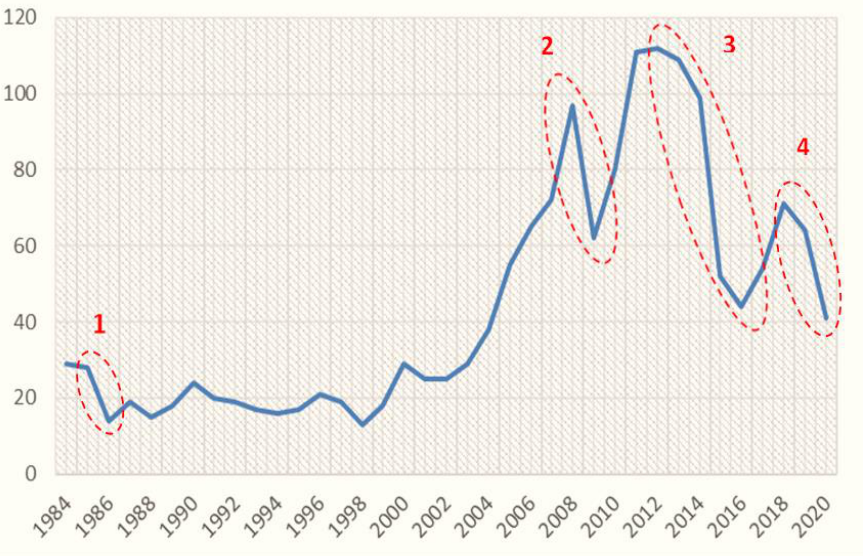
Figure 1. Brent spot prices 1984–2020, USD per barrel. Source: Created by the authors, data from [49,50].